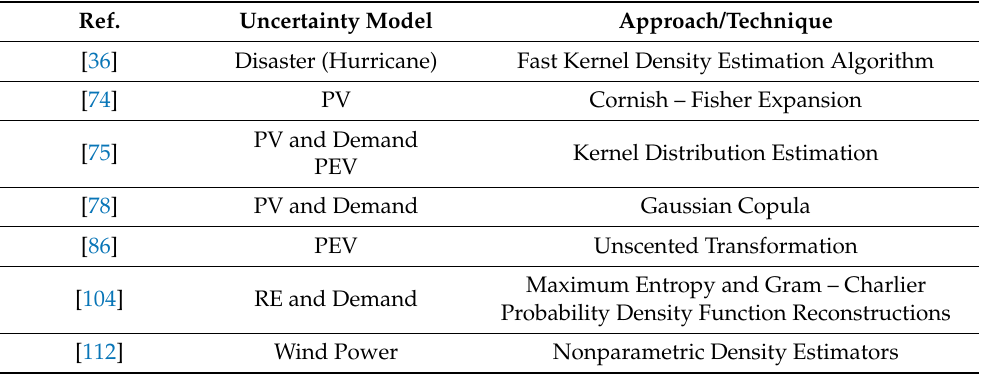
Table 11. Studies In Which PDF Approximation Is Used.